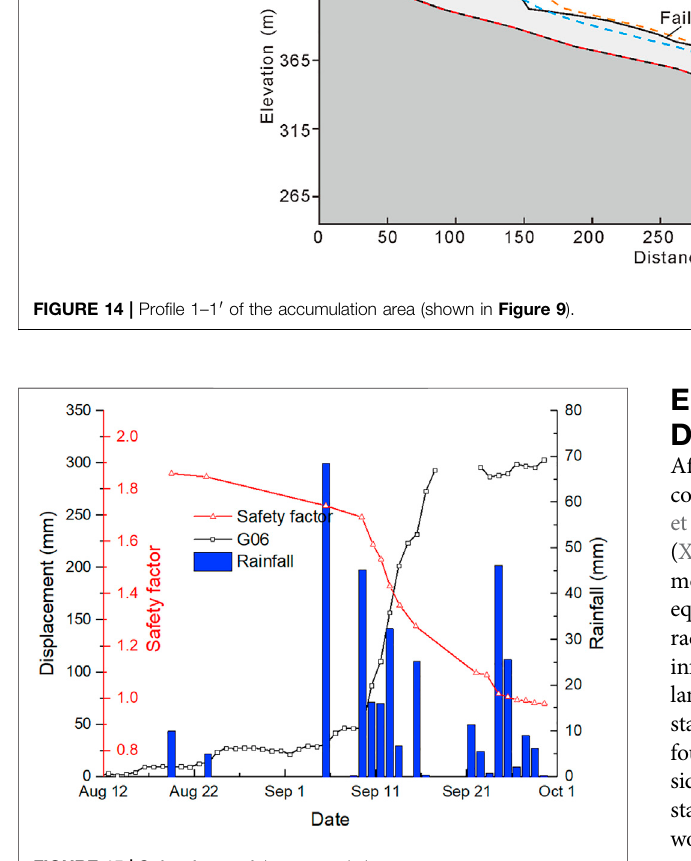
FIGURE 15 | Safety factor of the accumulation